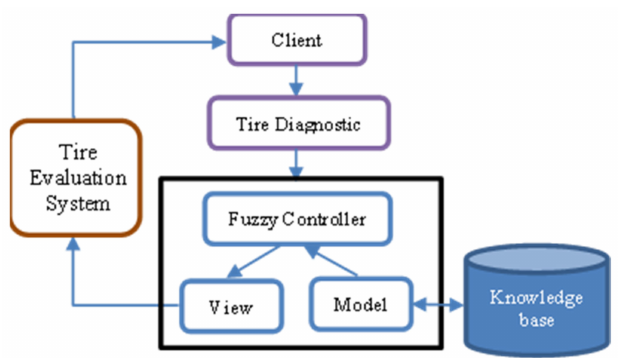
Figure 3. The architecture of the Fuzzy Controller View